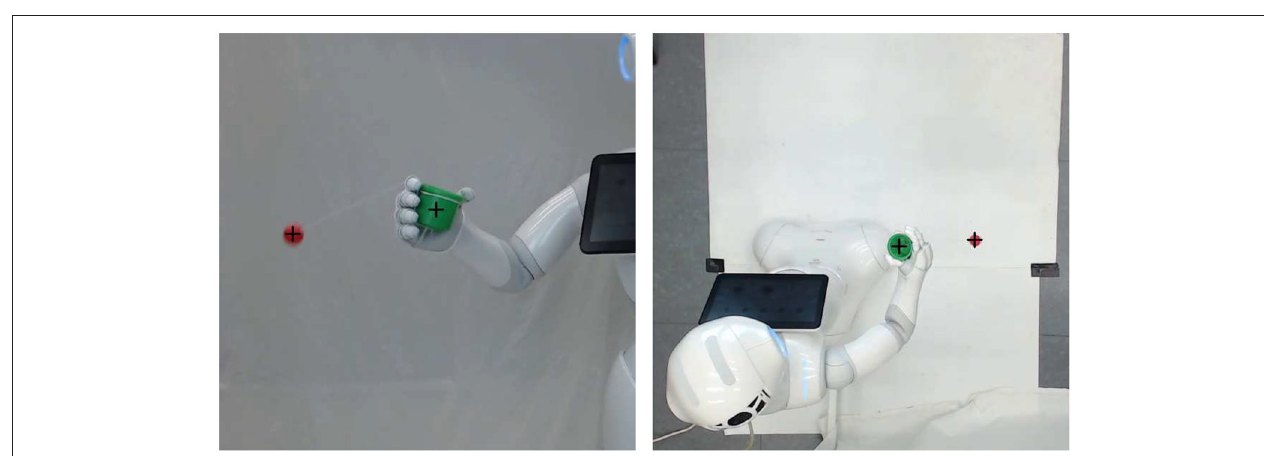
Frontiers in Robotics and AI |